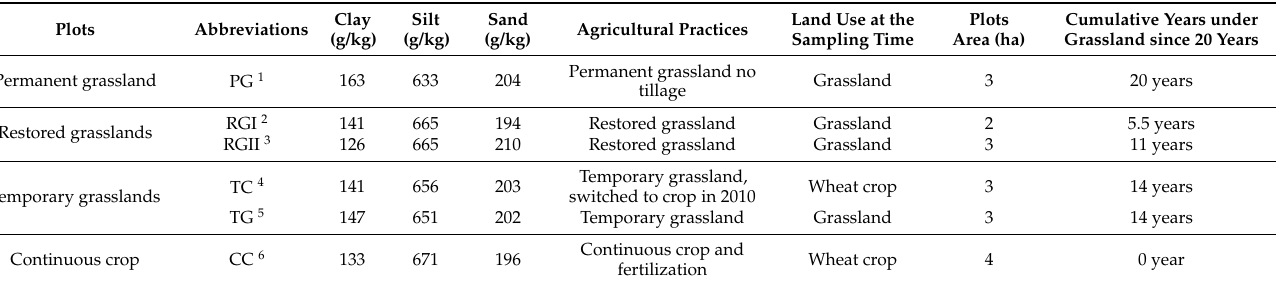
Table 1. Description of the studied plots.